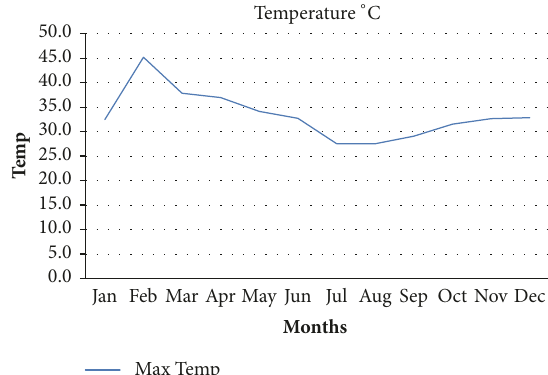
Figure 2: Maximum temperature during the cropping season (2016, Tigray Regional Meteorological Agency